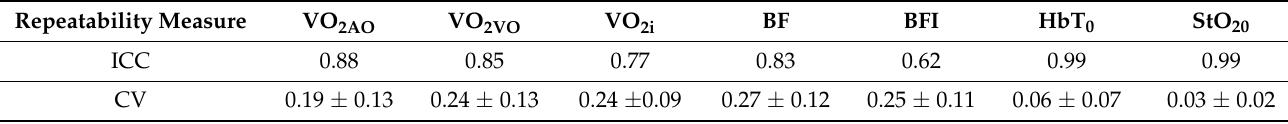
Table 3. Measurement Repeatability. Intraclass correlation coefficients (ICC) and mean ± standard deviation coefficients of variation (CV) for oxygen metabolism measured during arterial occlusion and venous occlusion (VO 2AO and VO 2VO , respectively), as well as oxygen metabolism index (VO 2i ), blood flow measured during venous occlusion (BF), blood flow index (BFI), total hemoglobin concentration (HbT 0 ), and oxygen saturation (StO 20